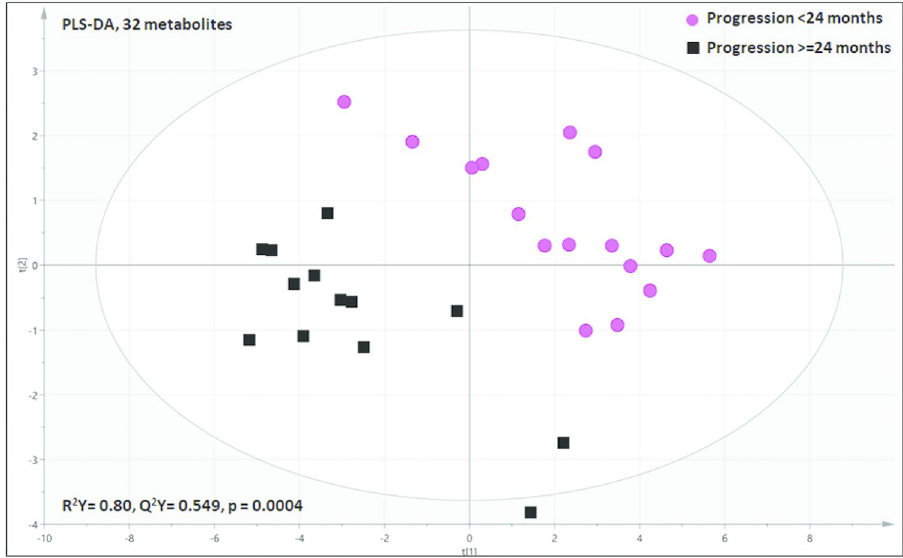
Figure 4. Partial least squares discriminant analysis highlighting good separation of FL cases with early progressive disease (< 24 months) and those who experienced later progressive disease (≥ 24 months) using 30 metabolites with the highest effect magnitude (Q2Y = 0.549; p =